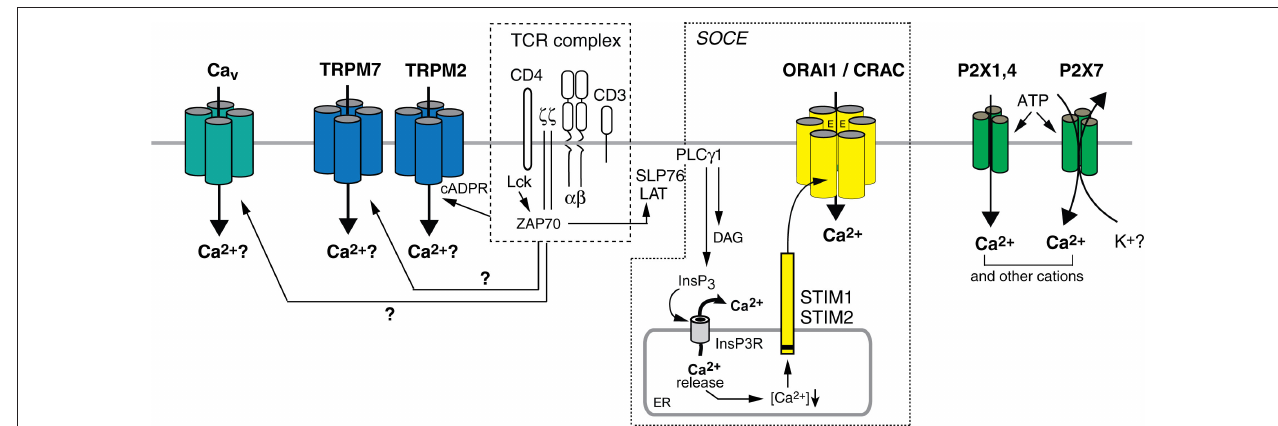
channel that can be activated by cADPR and NAADP in human T cells (Beck Figure 1 | Ca 2+ influx pathways in T cells. Stimulation of T cells through the et al., 2006). Increased cADPR levels after TCR stimulation (Guse et al., 1999) TCR complex results in Ca 2 + influx, which is involved in the regulation of many activate SOCE by releasing Ca 2 + from the ER through RyR channels and T cell functions. CRAC channels mediate store-operated Ca 2+ entry (SOCE) potentially activate TRPM2 channels directly. TRPM7 is a non-selective cation following activation of PLC γ 1 and production of InsP . InsP binds to and opens 3 3 channel implicated in Mg 2 + homeostasis in T cells; whether its ability to Ca 2 + permeable InsP receptors (InsP R) in the ER, resulting in the release of 3 3 conduct Ca 2 + contributes to T cell function and how it is activated by Ca 2 + from ER stores (Lewis, 2001; Feske, 2007). Ca 2 + release from the ER causes the activation of STIM 1 and 2, which oligomerize and translocate to ER-plasma membrane junctions. STIM1 and STIM2 bind to ORAI1, the pore-forming subunit of the CRAC channel, thereby mediating its opening and sustained Ca 2 + influx. The subunit composition of the CRAC channel awaits further studies; both tetrameric and hexameric assemblies of ORAI1 subunits were proposed (Ji et al., 2008; Mignen et al., 2008; Penna et al., 2008; Maruyama et al., 2009; Hou et al., 2012). TRPM2 is a Ca 2 + permeable cation